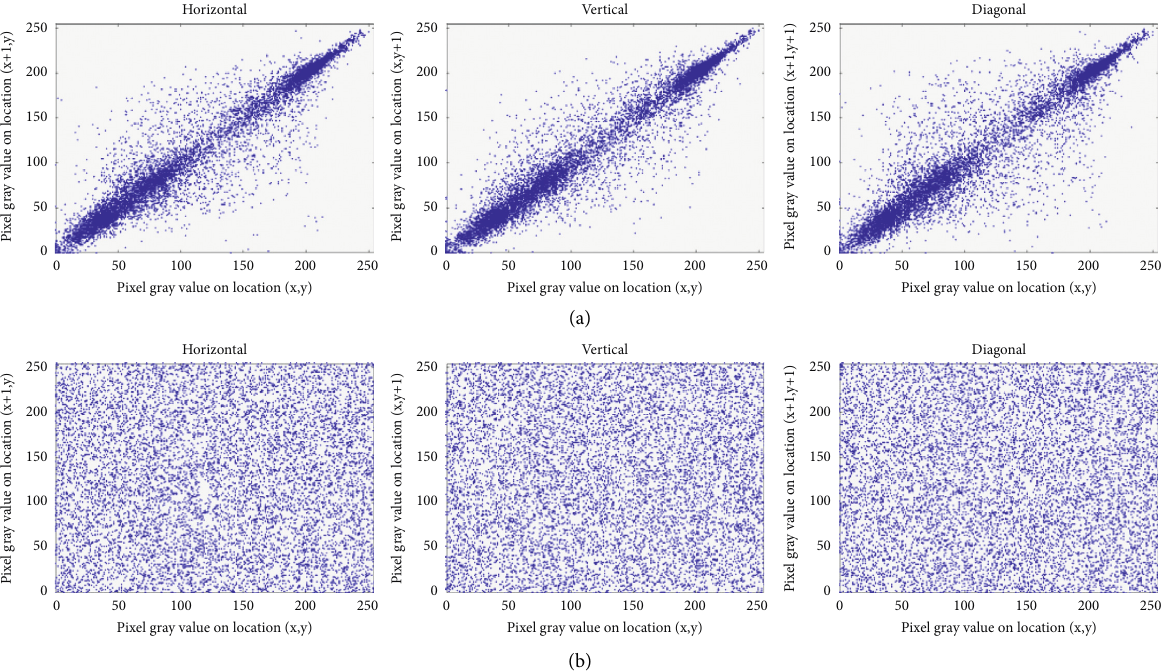
Figure 8: Correlation distribution for blue component of plain composite image in Figure 4(a) (a) and those from the cipher composite image in Figure 4(b) (b).